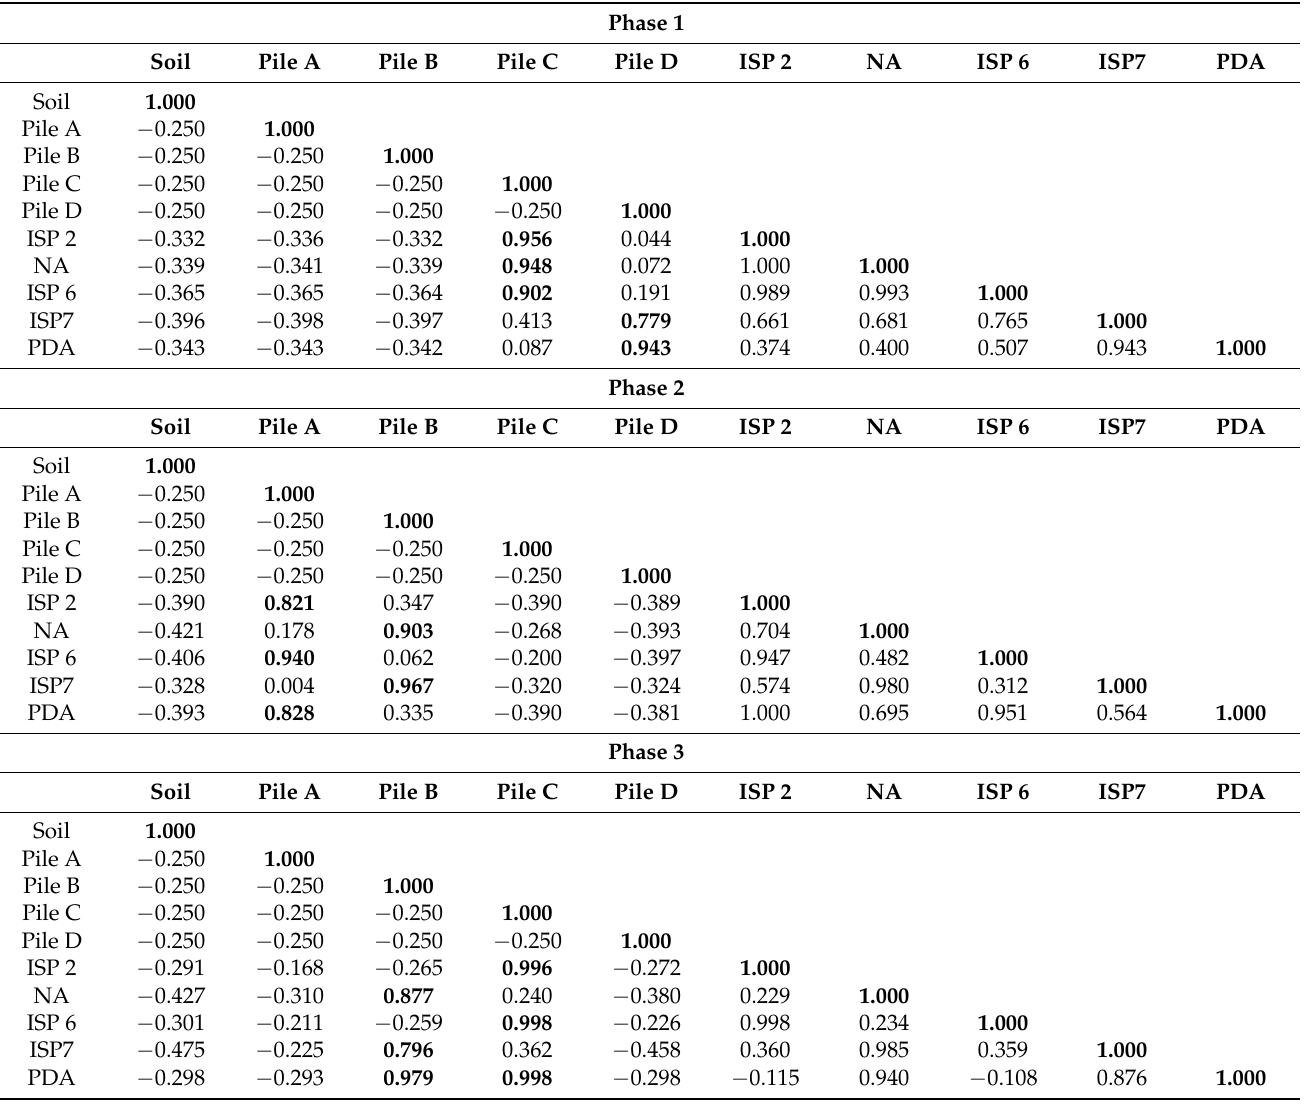
Table 1. Pearson correlation of all the pile mixes and culture media in phases 1, 2, and